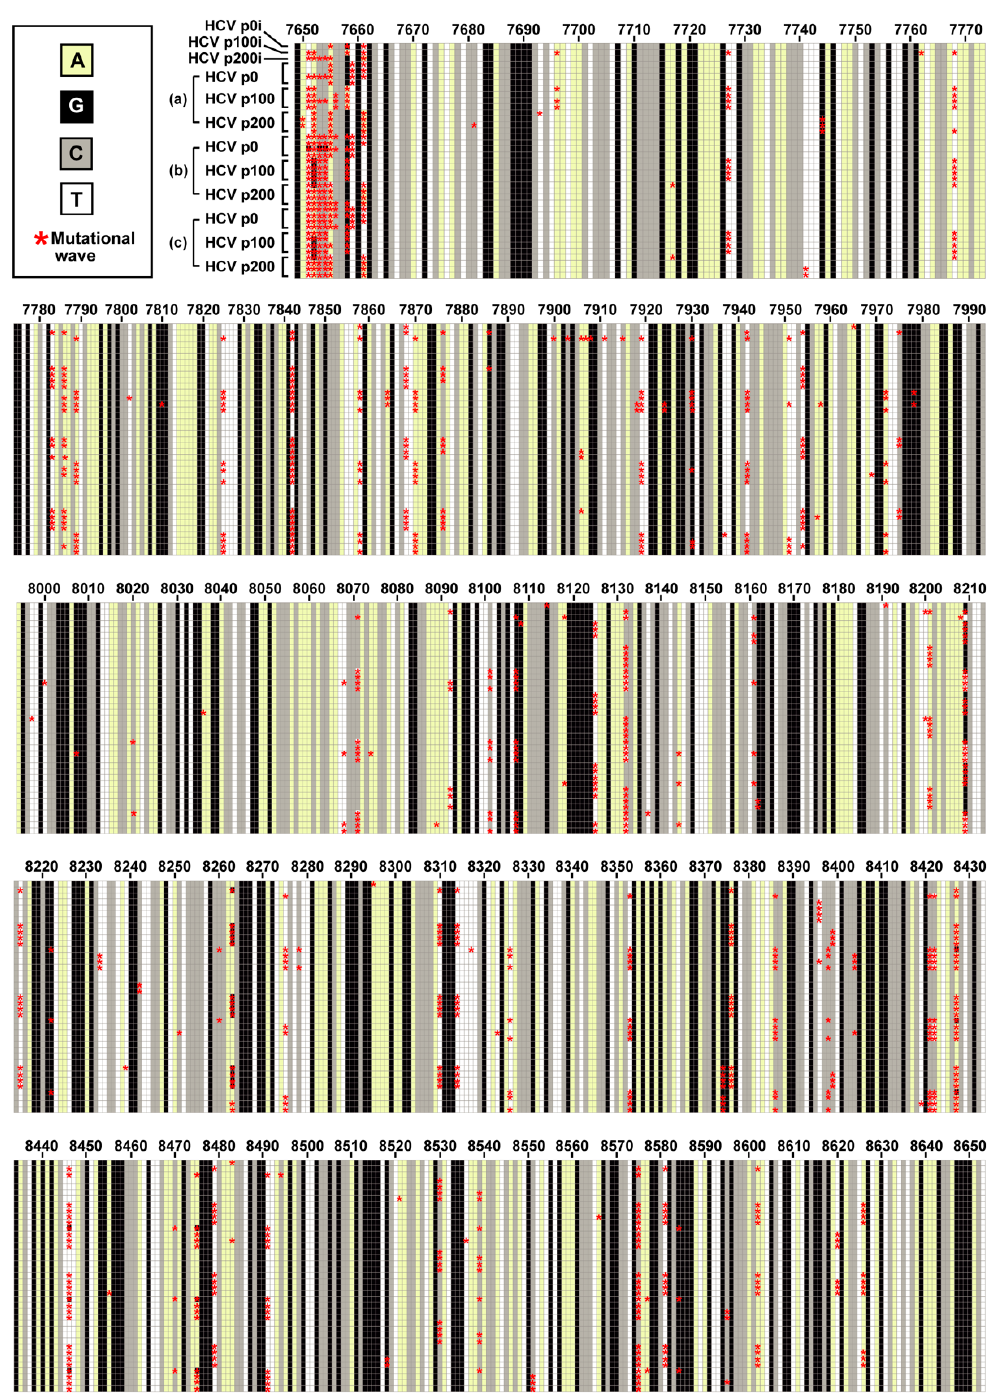
Figure 2. Heat map of consensus sequences of 39 HCV populations derived from HCV p0 upon passage in Huh-7.5 cells. The region analyzed by deep sequencing spans genomic residues 7649 to 8653 (residue numbering according to reference isolate JFH-1). The populations are those identified by empty circles in the HCV passage diagram of Figure 1A, and are indicated at the left of the top bloc of the alignment; (a), (b), and (c) refer to the three replicas of the four serial passages of HCV p0, HCV p100 and HCV p200. Each horizontal alignment of squares displays the consensus sequence (1005 nucleotide positions) of the population written on the left, with the nucleotide color code given in the upper box on the left. The red asterisks indicate the nucleotides that participated in mutational waves (that is, that changed in frequency among any of the populations analyzed). The complete set of mutations and deduced amino acid substitutions are given in Table S1 .